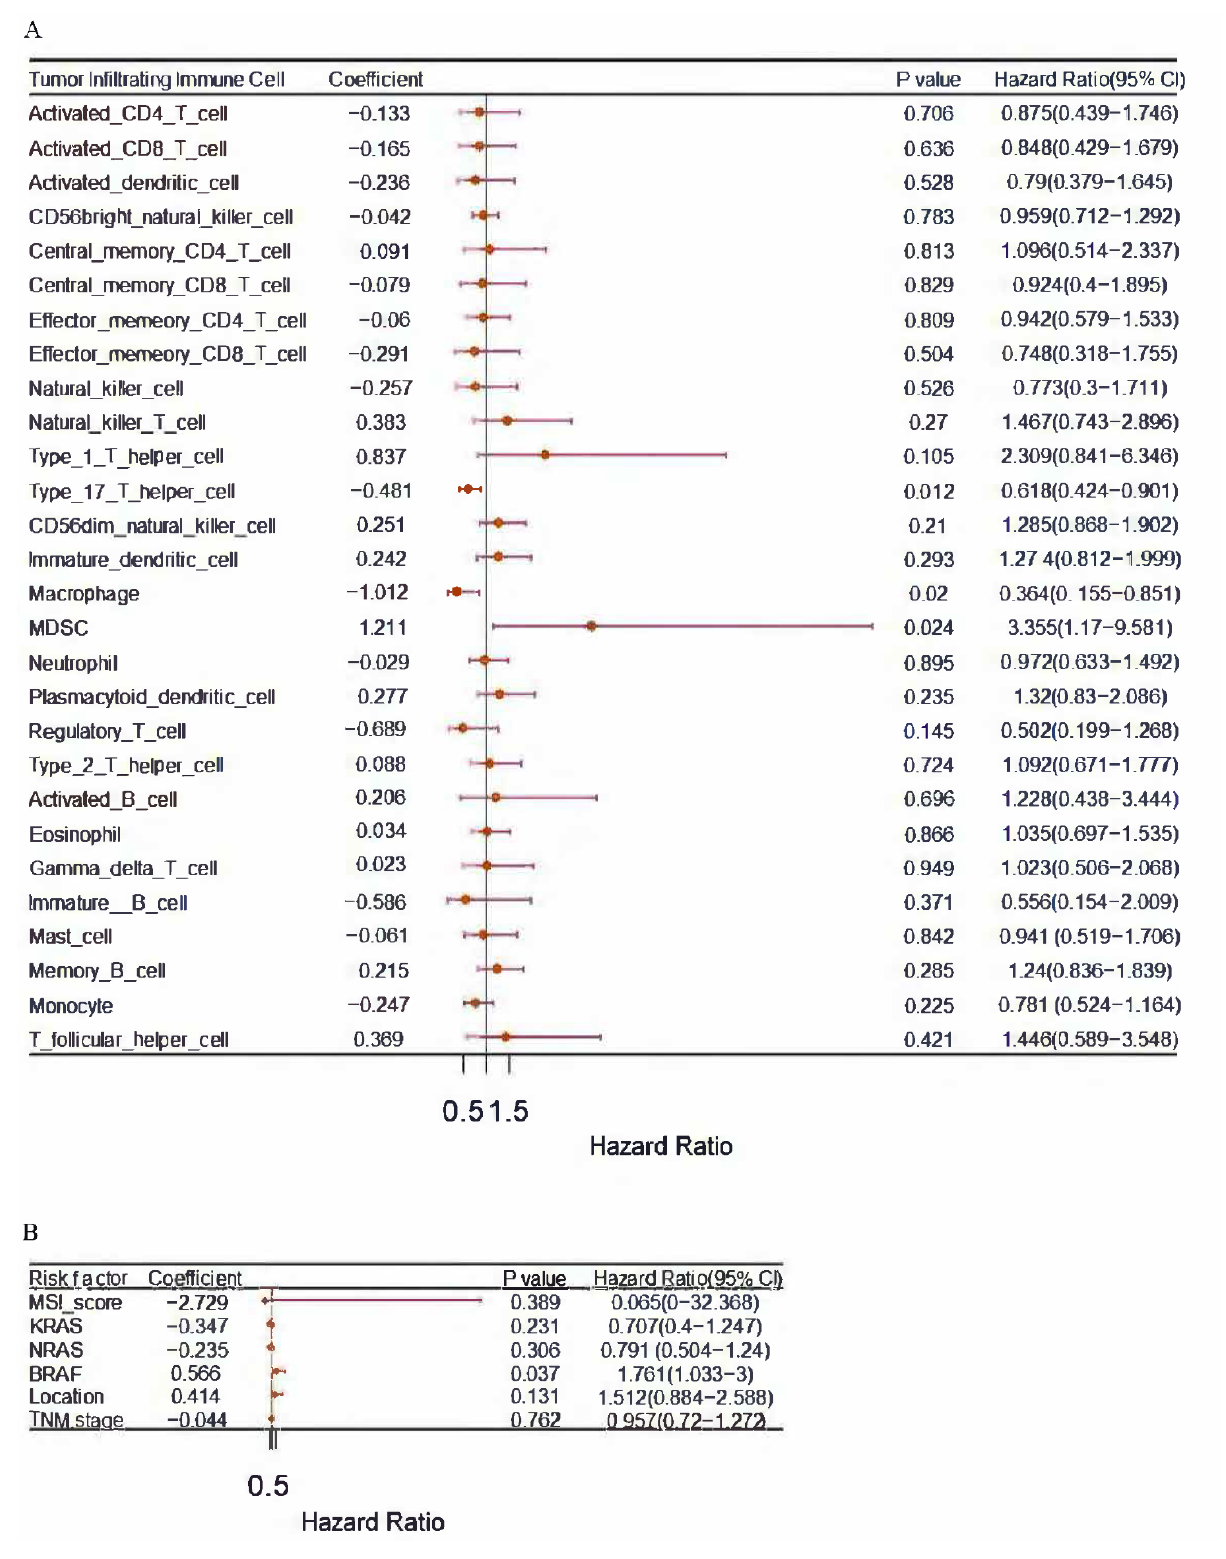
Figure 2. ( A ) Analyzed immune cells from The Cancer Genome Atlas using Univariate Cox regression; ( B ) Analyzed Risk factors including MSI score, KRAS, NRAS, BRAF, tumor location and TNM stage from The Cancer Genome Atlas using Univariate Cox regression; p less than 0.05. MDSCs (HR greater than 1) were analyzed, suggesting a negative role for MDSCs in colon